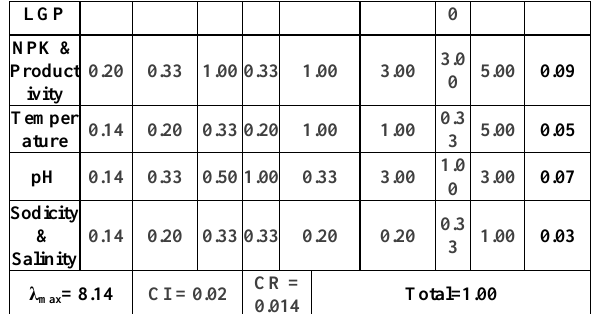
Table 5. Soil site requirement for Cereals (NBSSLUP)